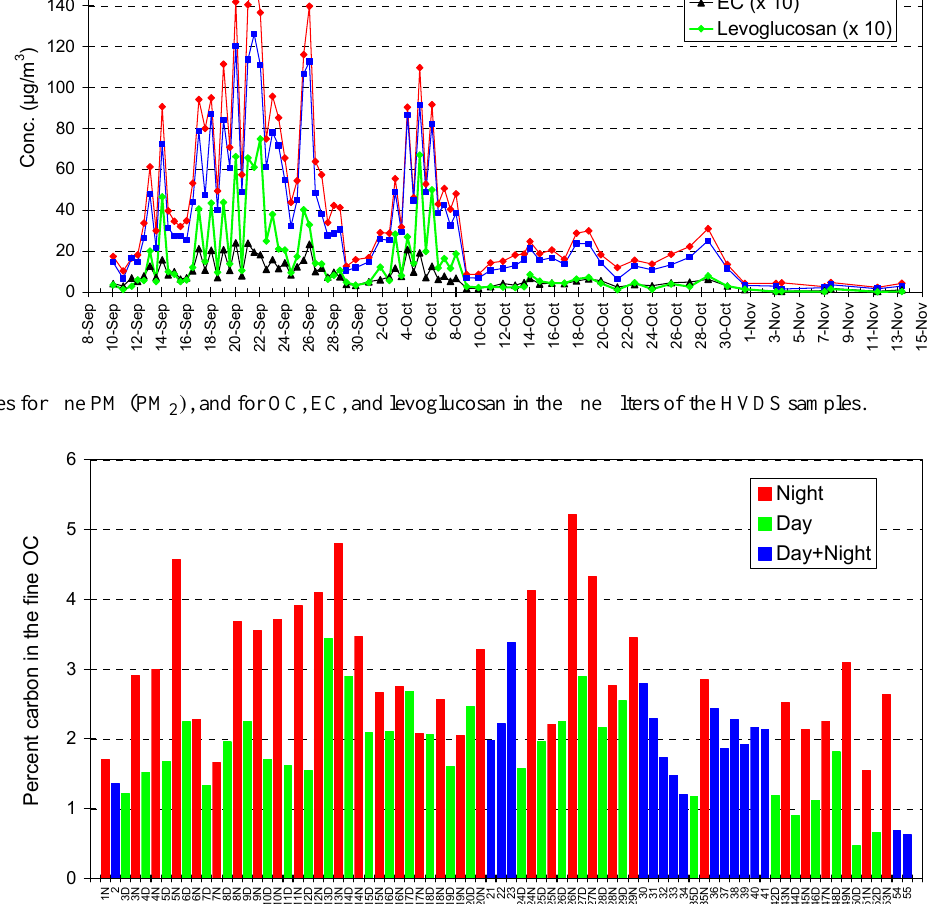
Fig. 3. Time series for the levoglucosan carbon as percent of the fine OC in the HVDS samples. Samples 1N through 29N are from the dry period, 30 through 48D from the transition period, and 49N through 55 from the wet